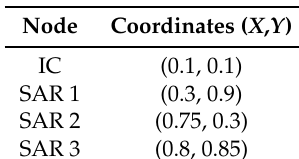
Table 1. Positions of the first response teams at the initial deployment stage.